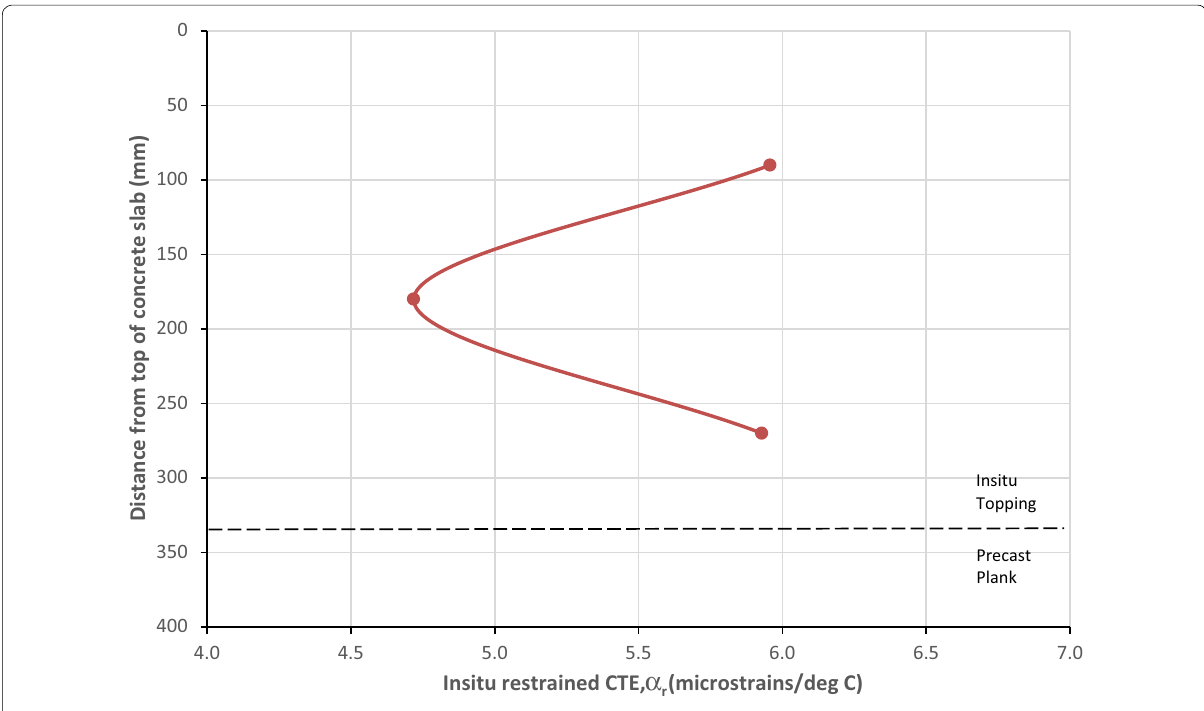
Fig. 15 Variation of in situ restrained coefficient of thermal expansion in